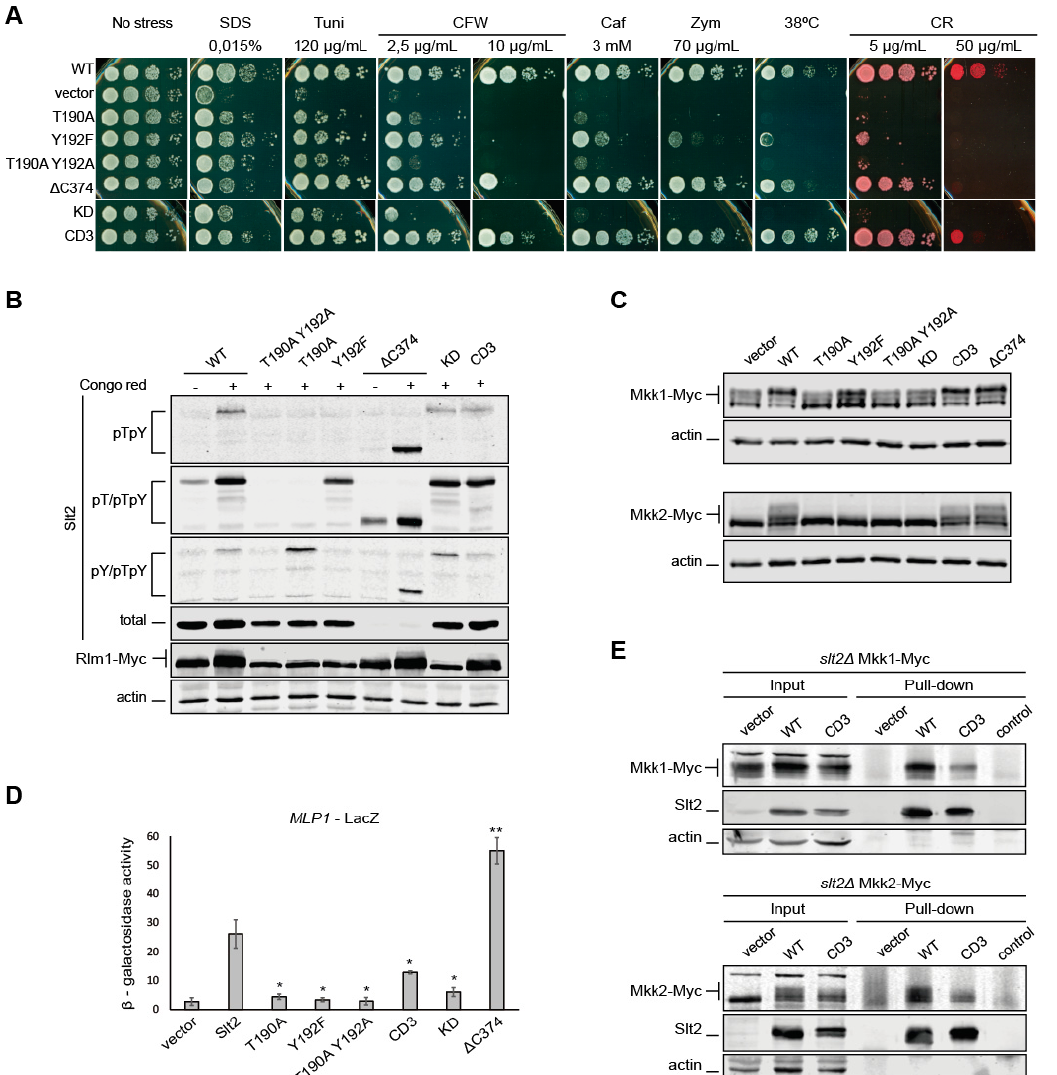
Figure 5. Analysis of the activity of different mutant versions of Slt2. ( A ) Ten-fold serial dilutions of BY4741 slt2 ∆ -RLM1Myc cells bearing the pRS316 plasmid alone (vector) or expressing Slt2 (WT), Slt2 T190A , Slt2 Y192F , Slt2 T190A Y192A , Slt2 ∆ C374 , Slt2 KD , or Slt2 CD3 . Cells were spotted onto YPD plates in the absence (no stress) or presence of Sodium Dodecyl Sulfate (SDS), tunicamycin (Tuni), Calcofluor White (CFW), caffeine (Caf), zymolyase (Zym), and Congo Red (CR) at the indicated concentrations. ( B ) The same cells as in ( A ) were grown to the mid-exponential phase in YPD and then stimulated with 30 µ g/mL of CR for 2 h. Cell extracts were resolved by SDS–PAGE, and analyzed by immunoblotting with anti-Slt2-pTpY, anti-Slt2-pT/pTpY, and anti-Slt2-pY/pTpY, as in Figure 1; anti-Mpk1 (total); anti-Myc 4A6; and anti-actin antibodies. ( C ) Extracts from slt2 ∆ MKK1-myc (YMJ30 strain) or slt2 ∆ MKK2-myc (YMJ31 strain) cells transformed with the same plasmids as in ( A ) were resolved by SDS–PAGE, as in ( B ), and analyzed by immunoblotting with anti-Myc 4A6 and anti-actin antibodies. ( D ) β -galactosidase activity of cell extracts from slt2 ∆ (Y00993) cells co-transformed with p MLP1-LacZ and the same plasmids as in ( A ) after incubation with 30 µ g/mL of CR for 2 h. Data represent the average of the activity of three independent transformants. Error bars indicate the standard deviation. Asterisks (* and **) indicate p -values of <0.05 and <0.01, respectively, assessed by Student’s t-test, and refer to the Slt2 wild type (WT) activity. ( E ) The same strains as in (C), transformed with the pRS316 plasmid expressing Slt2 (WT) or Slt2 CD3 . Cells were grown to the mid-exponential phase in YPD and stimulated with 30 µ g/mL of CR for 2 h. Cell extracts (input) were incubated with the anti-Mpk1 antibody attached to Dynabeads™ Protein G to purify Slt2 complexes (pull-down) and resolved by SDS–PAGE. Proteins were detected with anti-c-Myc, anti-Mpk1 (Slt2), and anti-actin antibodies by immunoblotting. A control of the Dynabeads-Mpk1 antibody non-incubated with cell extracts is included. A representative assay from three different experiments with distinct transformants is